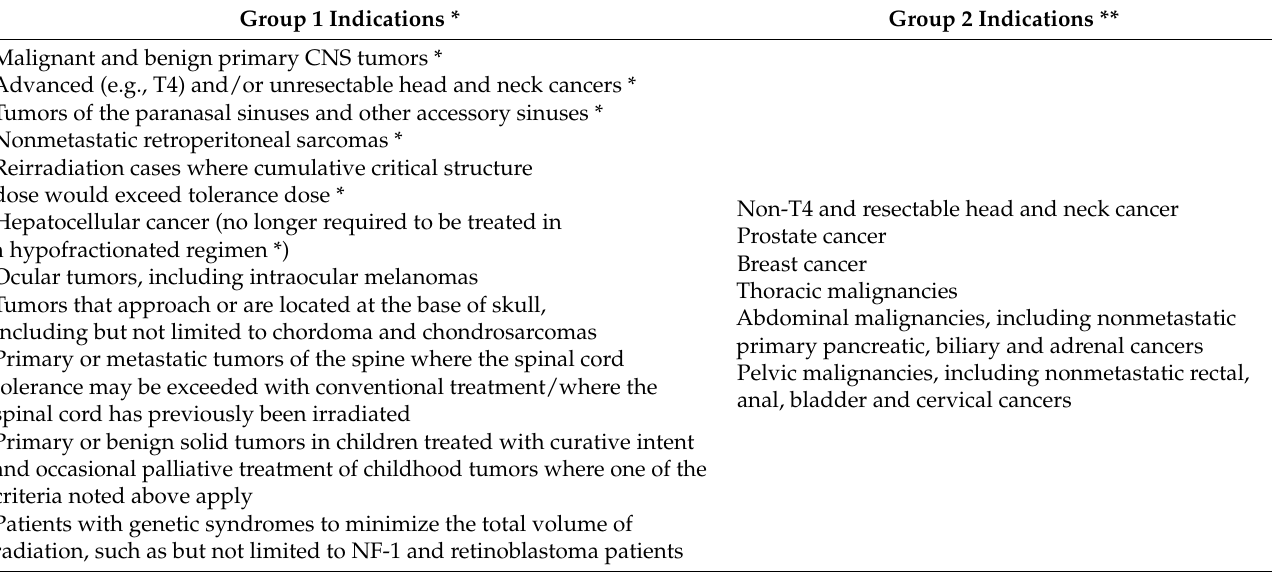
Table 2. ASTRO updates on insurance coverage recommendations for proton